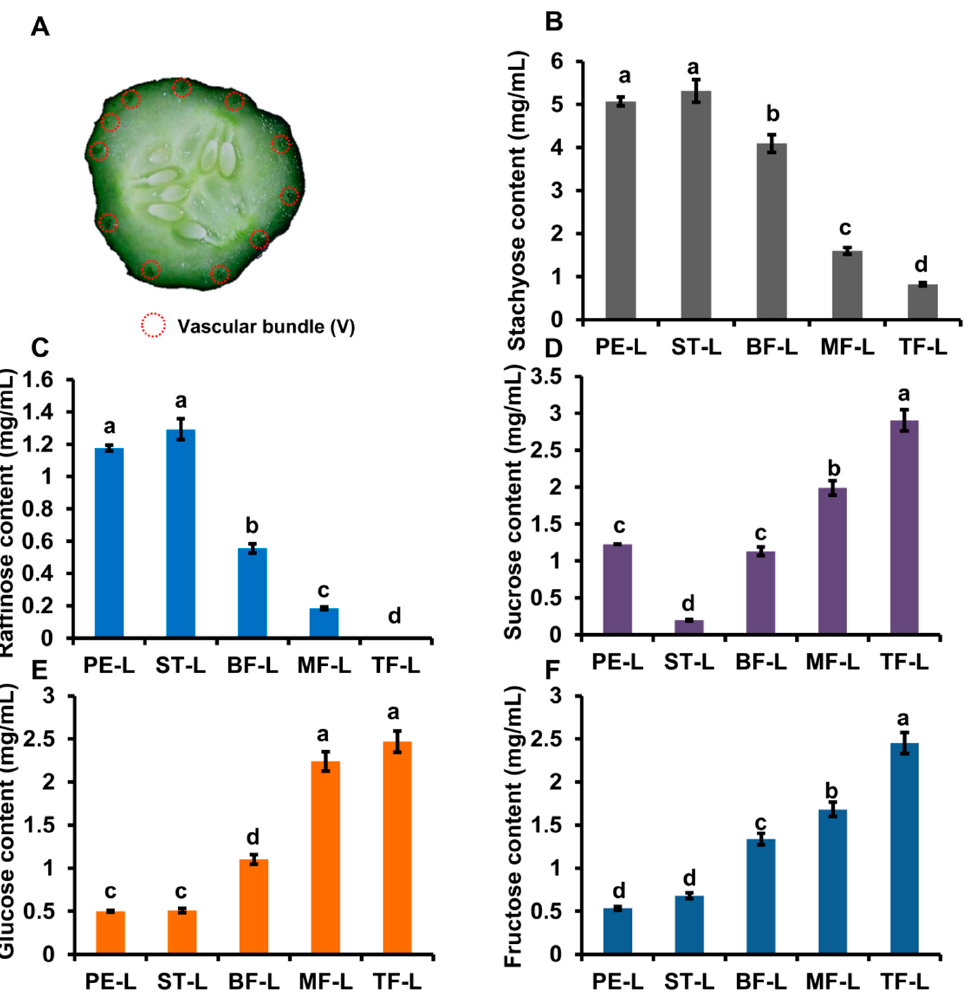
Figure 2. The distribution of soluble sugar in phloem sap of fruits. ( A ) The schematic diagram shows the collected sites of phloem sap. ( B – F ) The Sta ( B ), Raf ( C ), Suc ( D ), Glu ( E ) and Fru ( F ) content of phloem sap in pedicel (PE), stalk (ST), basal part(BF), middle part(MF) and top part(TF) of fruit. The bars represent standard deviation (SD) of five biological replicates. Bars marked with different letters denote significant differences ( p < 0.05) from Student’s t -test.